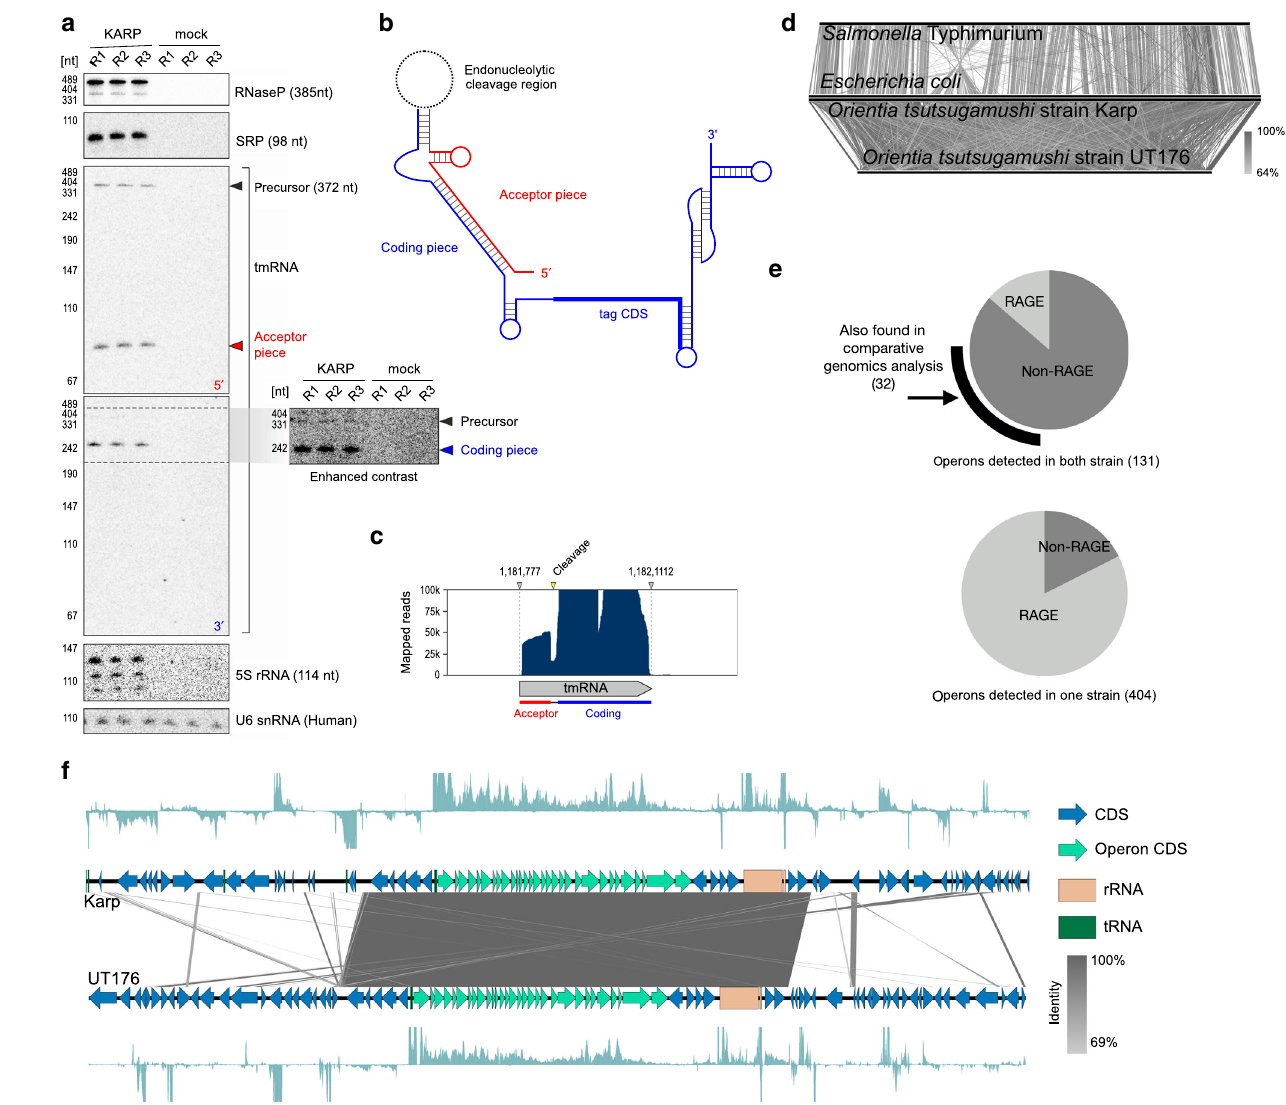
Fig. 2 RNA biology in Ot. a Northern blot analysis of core non-coding RNAs in Ot, showing results of three independent biological replicates. b Structure of the two-piece tmRNA observed in the Ot transcriptome. c RNA-seq read coverage over the tmRNA gene mirrors cleavage observed by Northern blot. d A comparison of genomic synteny of two species within the enterobacteriaceae ( Escherichia coli MG1655 and Salmonella enterica serovar Typhimurium SL1344, top), with synteny between the two Orientia strains from this study (bottom). e Pie charts illustrating the relative abundance of RAGE genes in conserved (top) and strain-speci fi c (bottom) operons. f Visualization of the largest conserved operon in Ot, encoding multiple ribosomal genes, showing RNA-seq coverage in both strains. Source data are provided as a Source Data fi